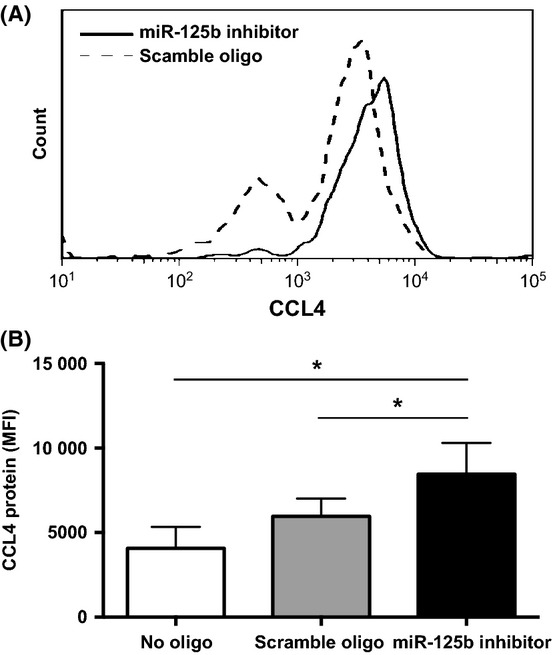
Reduction of miR-125b levels in monocytes resulted in increased CCL4 protein expression. (A) A representative graph of CCL4 staining in monocytes transfected with hsa-miR-125b miRCURY™ LNA inhibitor or a scrambled oligonucleotide. (B) Level of CCL4 protein (MFI) in monocytes transfected with hsa-miR-125b miRCURY™ LNA inhibitor or a scrambled oligonucleotide or no oligo. Freshly isolated monocytes were transfected with either hsa-miR-125b miRCURY™ LNA inhibitor (N = 13), or a scrambled oligonucleotide (N = 13), or no oligo (N = 6) for 16 h and followed by LPS stimulation for 3 h. Cells were harvested, and the levels of intracellular CCL4 protein were measured by the mean fluorescence intensity under the gate of positively transfected cells based on the oligonucleotide-linked fluorescein or no gate for no oligo transfection control.